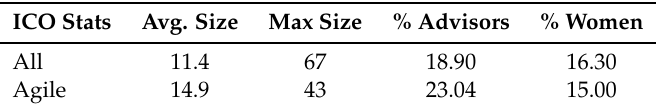
Table 1. Summary of statistics on ICO team. The average percentage of advisors and females per team are computed on teams of at least one